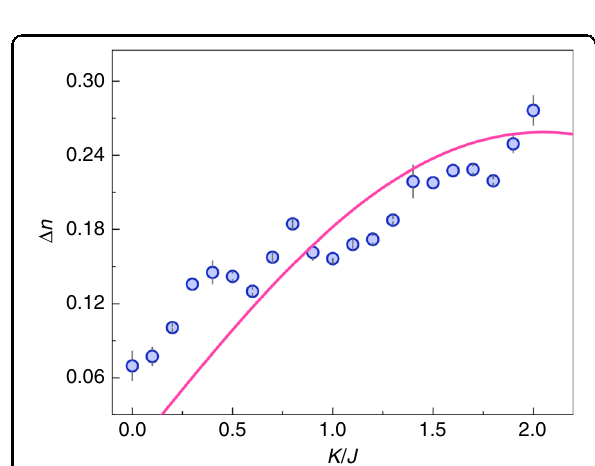
Fig. 4 Dependence of chiral atomic current on the inter-leg coupling. The population imbalance Δ n , characterizing the chiral atomic current in the ladder, as a function of the inter-leg coupling K after an evolution time of 160 µ s. The intra-leg tunneling energy is J/ ћ = 2 π ×500Hz and the gauge fl ux is Φ = π /4. The solid line represents the theoretical result from the numerical simulation of a noninteracting tight-binding